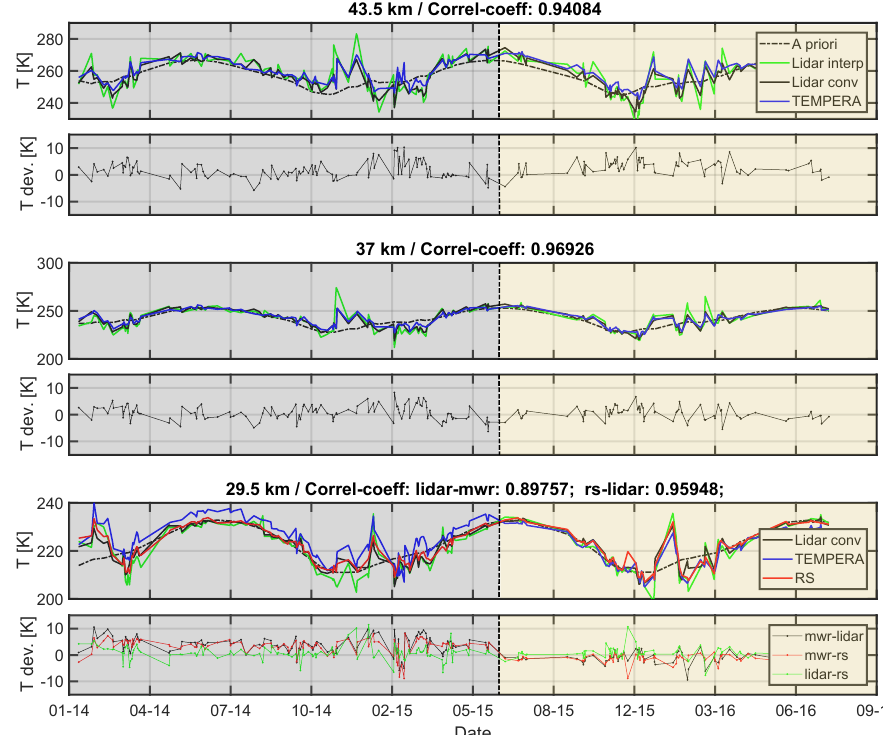
Figure 12. Stratospheric temperature evolution from TEMPERA, lidar and RS. Different background colours are used to distinguish between period 1 and 2 (grey and light brown,